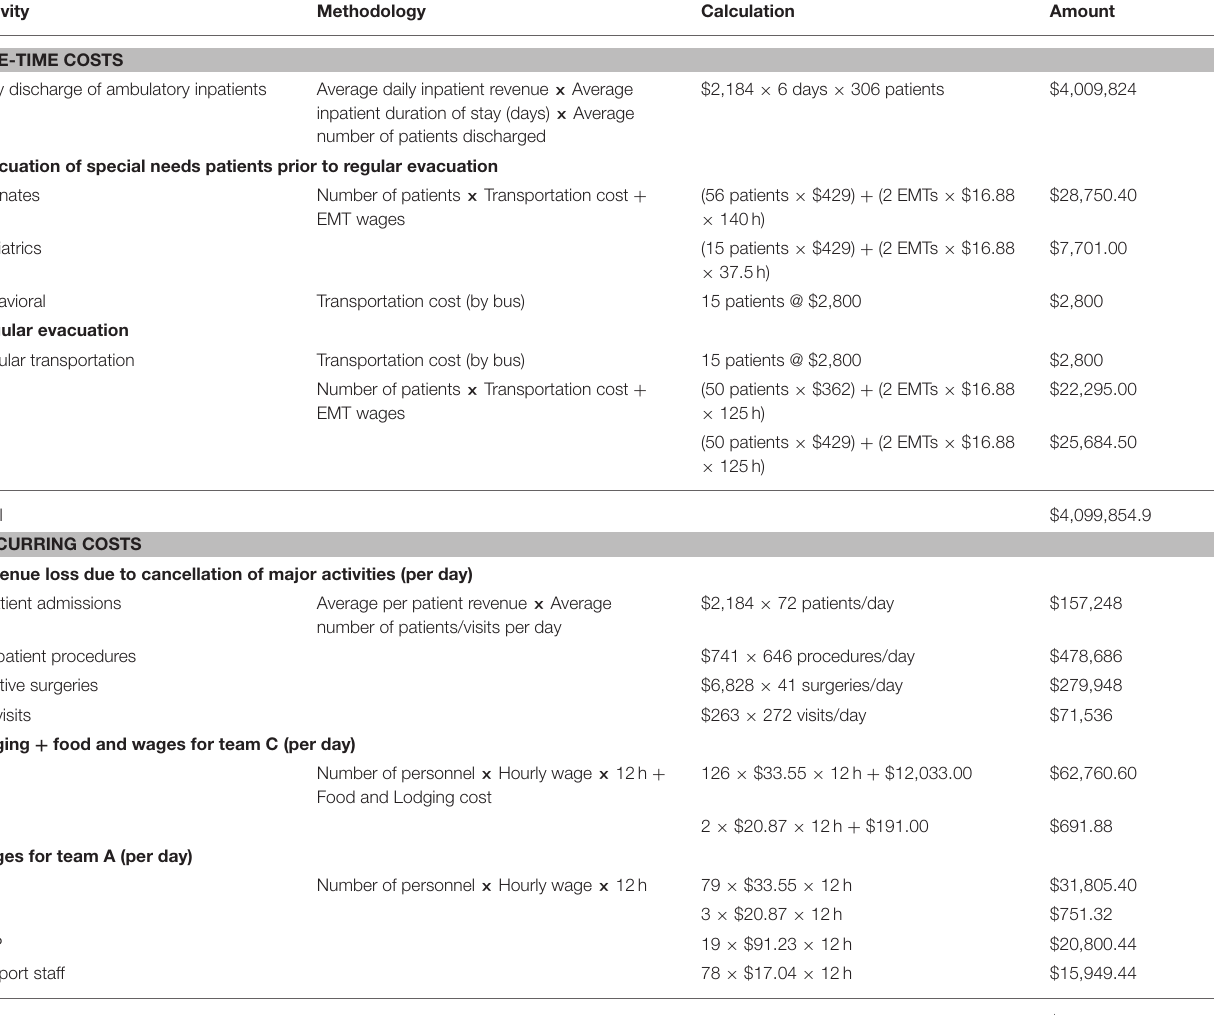
TABLE 2 | Cost calculations (one-time and recurring). Activity